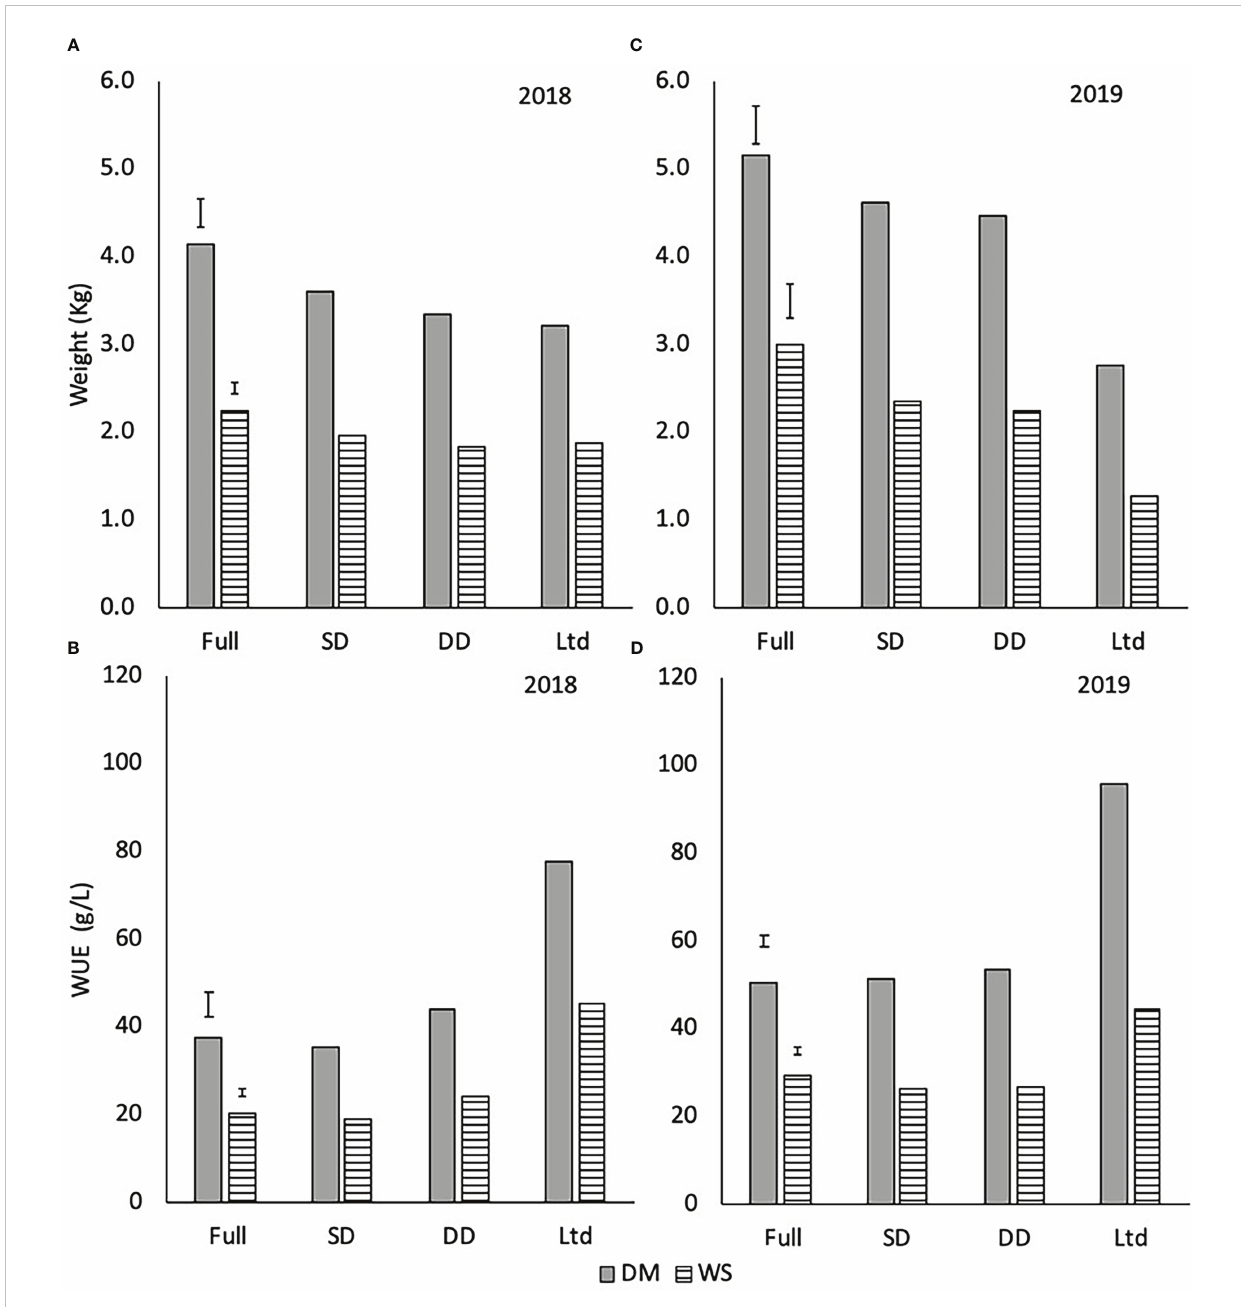
FIGURE 8 The amount of total dry matter (DM) and white sugar yield (WS) in 2018 (A) and 2019 (B) and dry matter water use ef fi ciency (WUE DM ) and white sugar yield water use ef fi ciency (WUE WS ) in 2018 (C) and 2019 (D) of sugar beet grown under four different irrigation regimes. (A) 2018 weights (DM LSD=0.322 DF=31 P<0.001 and WS LSD=0.142 DF=31 P<0.001). (B) 2019 weights (DM LSD=0.222 DF=31 P<0.001 and WS LSD=0.192 DF=31 P<0.001). (C) 2018 WUE (WUE DM LSD=5.76 DF=31 P<0.001 and WUE WS LSD=1.78 DF=31 P<0.001). (D) 2019 WUE (WUE DM LSD=2.52 DF=31 P<0.001, WUE WS LSD=2.09 DF=31 P<0.001). Error bars show irrigation LSD. Irrigation regimes were a fully irrigated (Full), a continually water limited kept at approx. 50% fi eld capacity (Ltd), a single drought (SD) (2018 65-96 DAS and 2019 73 -92 DAS) and a double drought (DD) which was exposed to the single drought treatment plus an additional drought (2018 151-200 DAS and 2019 118-182